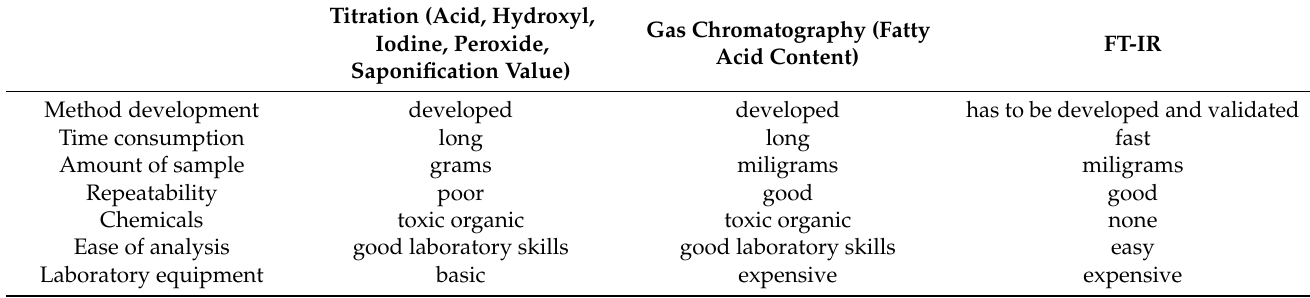
Table 4. Comparison of the FT-IR method and currently used methods for vegetable oil characterization.